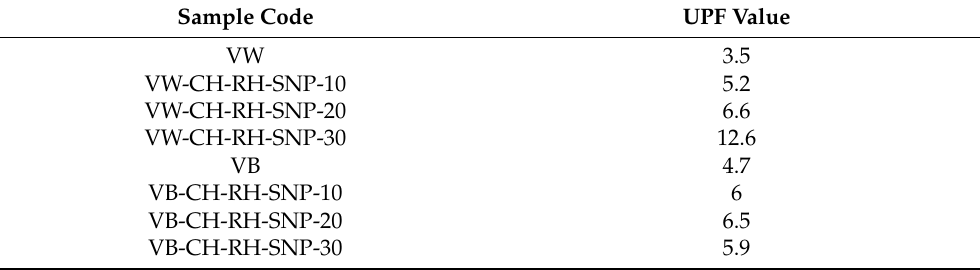
Figure 6. ( A ) TEM images of RH-SNP, AgNPs and RH-SNP-AgNPs and insets in ( A ) represent histogram of AgNPs. ( B ) Schematic diagram representing the synthesis of RH-SNP-AgNPs and their coating layer and treatment on textile fabrics. Reproduced with permission [10]. Copyright 2017, Elsevier. Table 2. Ultraviolet protection factor (UPF) values of 280–400 nm of uncoated and coated textile samples. Reproduced with permission [2]. Copyright 2021, Taylor and